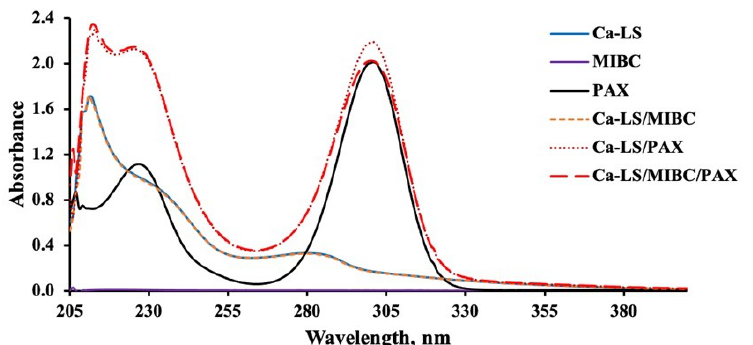
Figure 7. Absorbance spectra of Ca-LS (50 ppm), PAX (25 ppm) and MIBC (15 ppm), used in flotation without contacting the mineral in seawater.